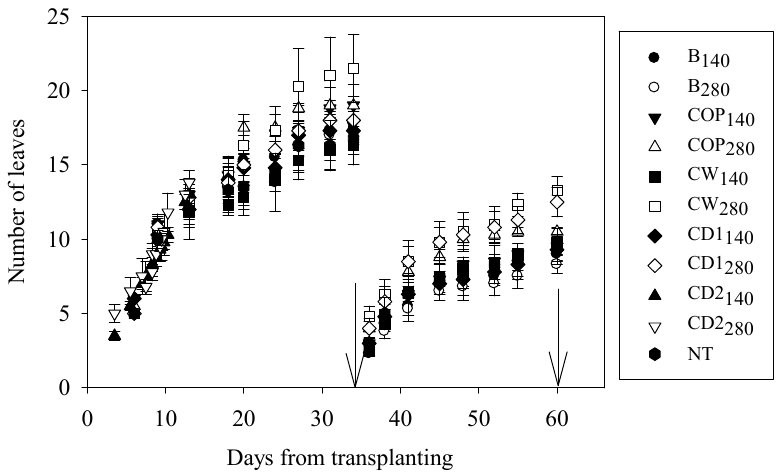
Figure 1. Number of leaves produced during 60 days after transplanting by Swiss chard plants treated with different organic amendments (B, biochar; COP, compost from olive pomace; CW, vermicompost from cattle manure; CD1, compost from 90% cattle anaerobic digestate with 10% wheat straw addition; CD2, compost from 79% cattle anaerobic digestate with 11% crop residues and 10% wheat straw addition), each added to provide 140 and 280 of kg N ha − 1 (black and white symbols, respectively), plus a non-treated soil or control (NT). The arrows indicate the first and second leaf cut (at 34 and 60 DAT, respectively). Values are means (n = 4) ± standard errors.